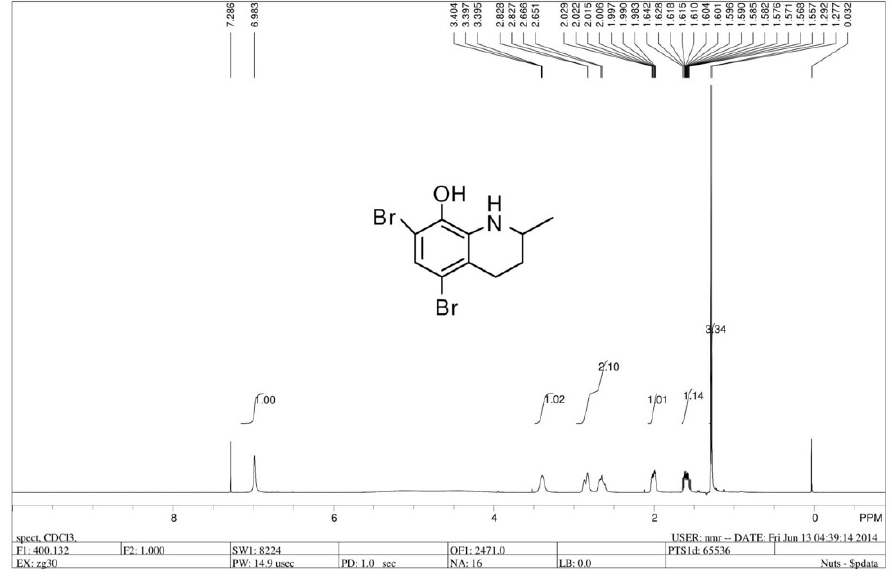
Figure 6. 1 H-NMR spectrum of compound 91b1.